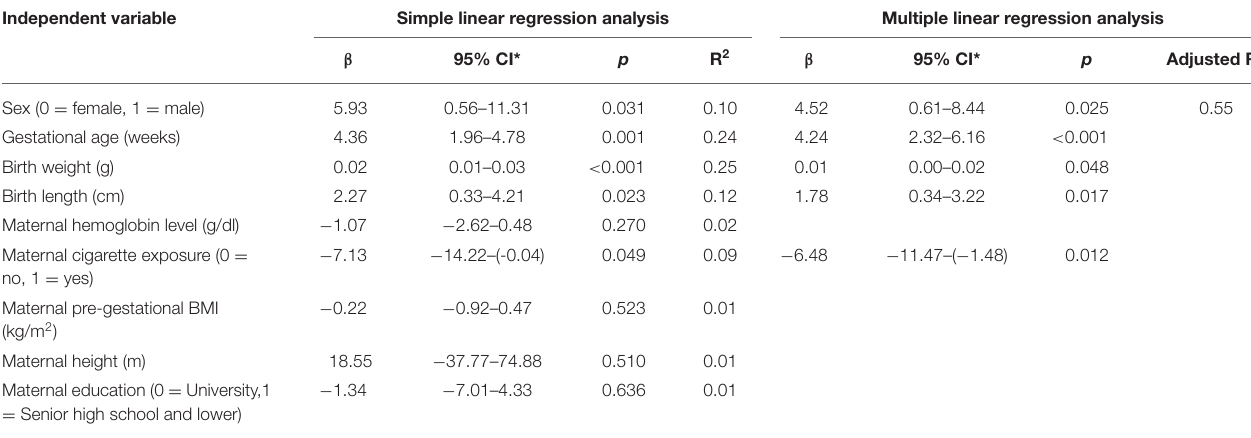
TABLE 4 | Determinants of WB BMC at birth by linear regression analysis. Independent